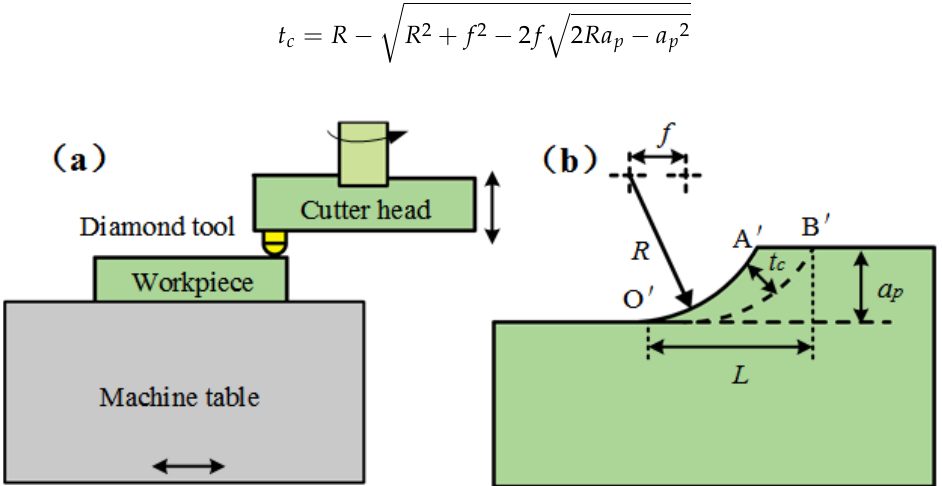
Figure 1. ( a ) Fly-cutting schematic diagram; ( b ) Undeformed chip thickness.